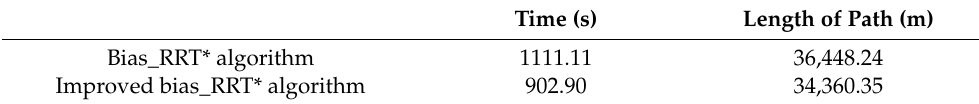
Table 3. Bias_RRT* algorithm comparison to the improved bias_RRT* algorithm in Scenario 2.